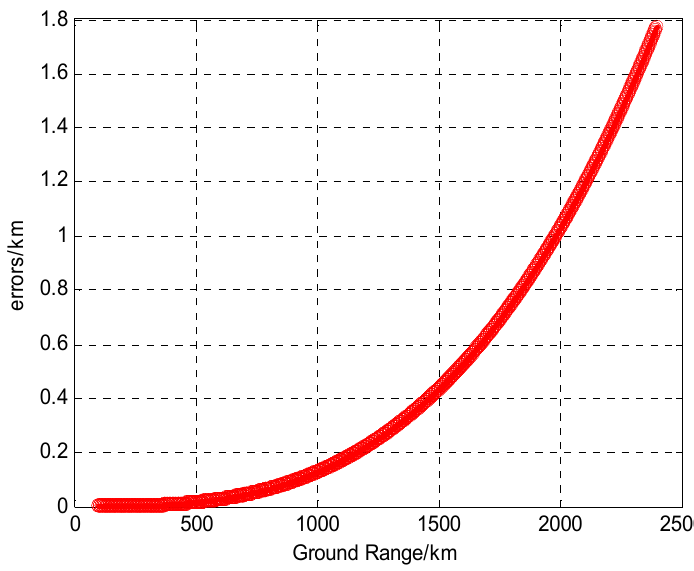
Figure 5. Transformation error of modes GS/SG mapping from Y - Rs to X - L .